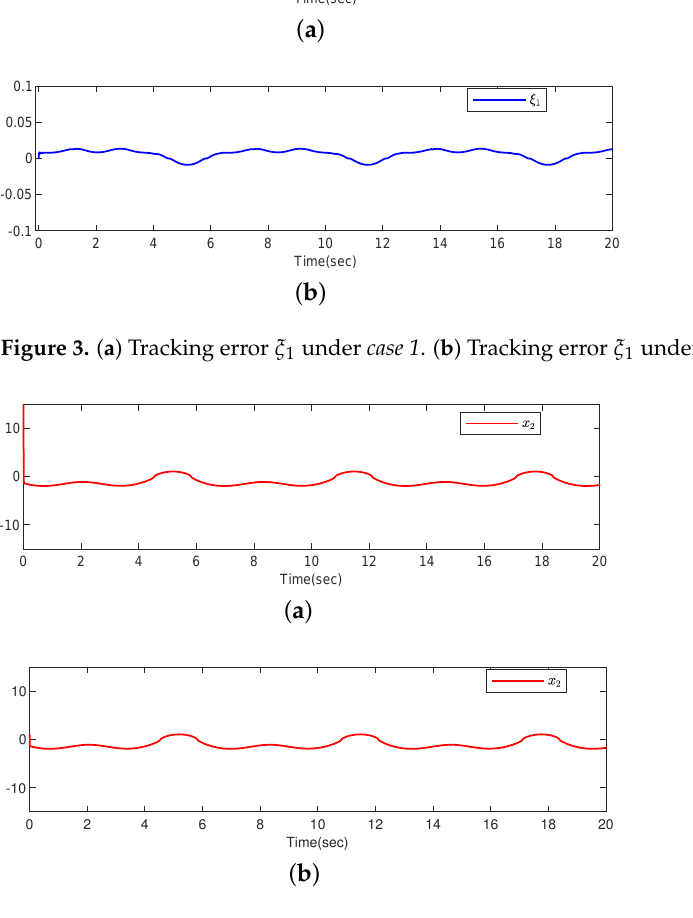
Figure 4. ( a ) System state x 2 under case 1 . ( b ) System state x 2 under case 2 .